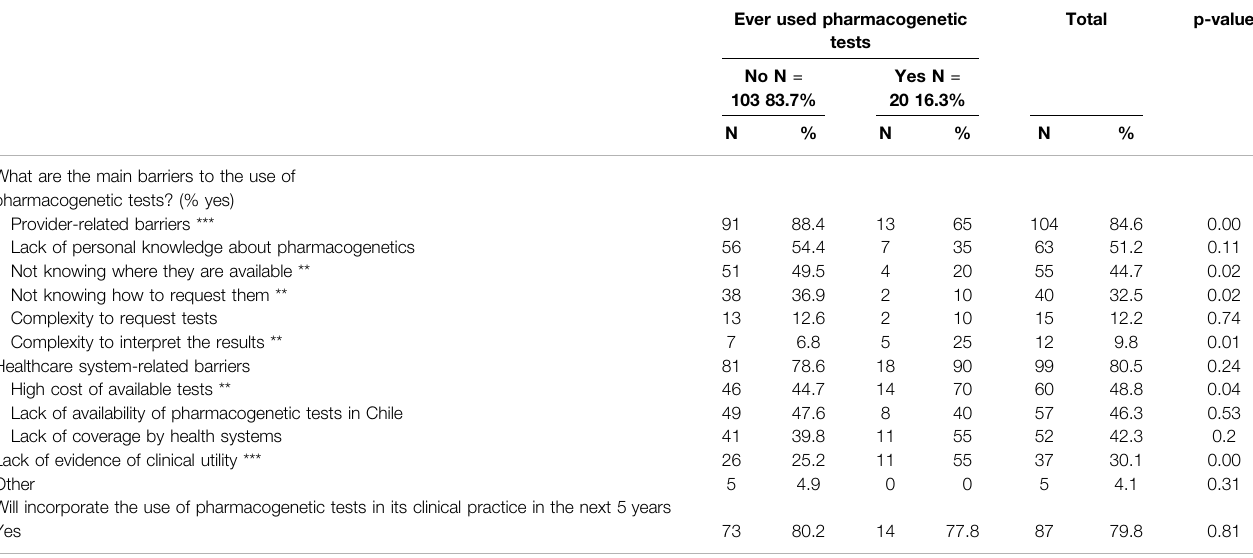
TABLE 2 | Perceived barriers to pharmacogenetic tests